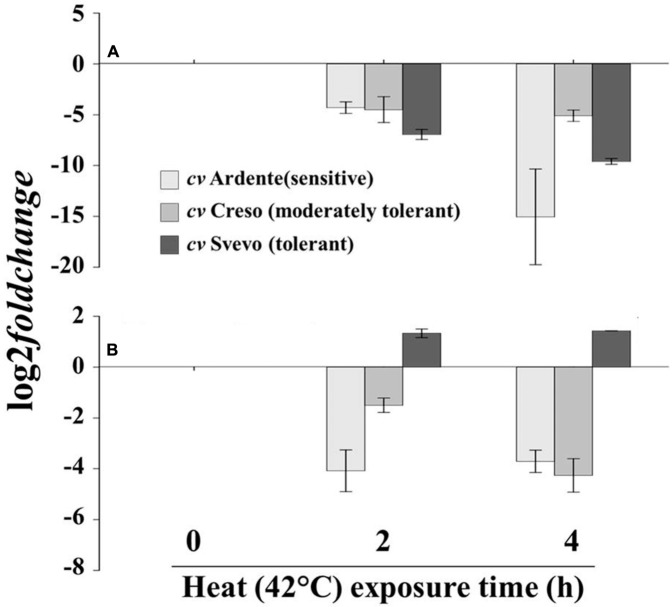
XTH expression profile in excised segment extracts of (A) the first 5 mm of the root apical region and (B) the root sub-apical region of 3-day-old wheat seedlings (cultivar Ardente, Creso, and Svevo) subjected to heat stress (42°C) for 2 and 4 h. XTH expression is reported as transcript inhibition level (log2 fold change) with respect to time 0 (control). Data are the mean ± standard deviation of three independent replicates (n = 3).